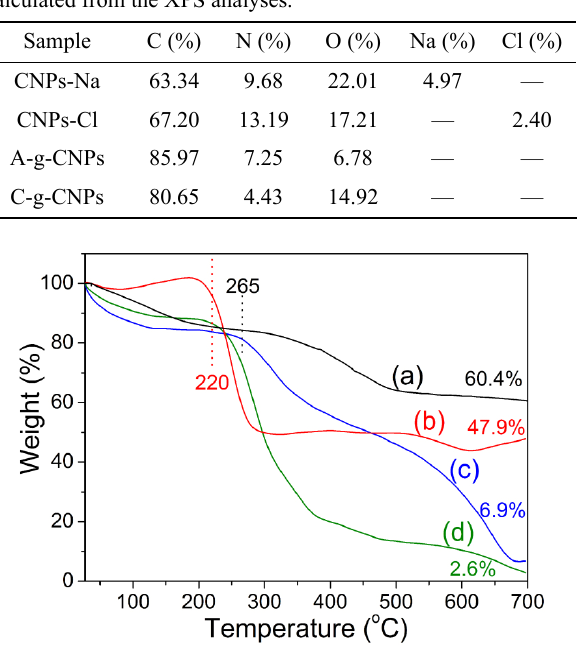
Fig. 6 TGA curves of (a) CNPs-Na, (b) CNPs-Cl, (c) A-g-CNPs, and (d)